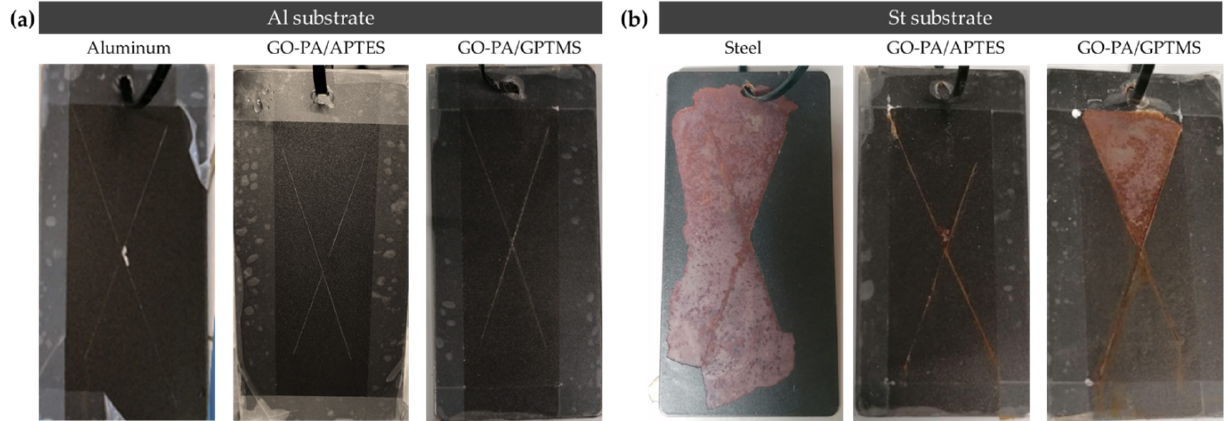
Figure 17. Visual images of painted aluminum ( a ) and steel ( b ) substrates without GO-PA nanofiller and with GO-PA nanofiller (as GO-PA/GPTMS and GO-PA/APTES coatings) after salt spray test (aluminum: 900 h; coated Al 1300 h; steel: 50 h; coated St: 400 h).